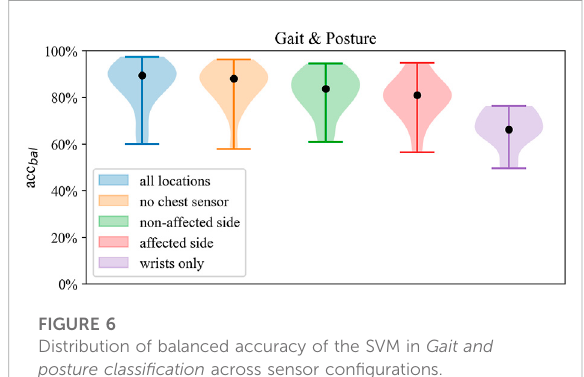
FIGURE 6 Distribution of balanced accuracy of the SVM in Gait and posture classi fi cation across sensor con fi